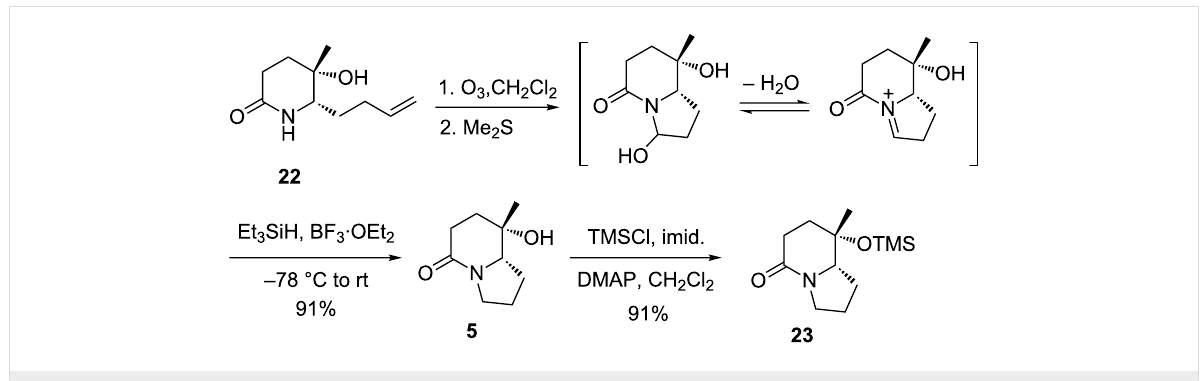
Scheme 9: Synthesis of (8 S ,8a S )- 5 and its silyl ether 23 .